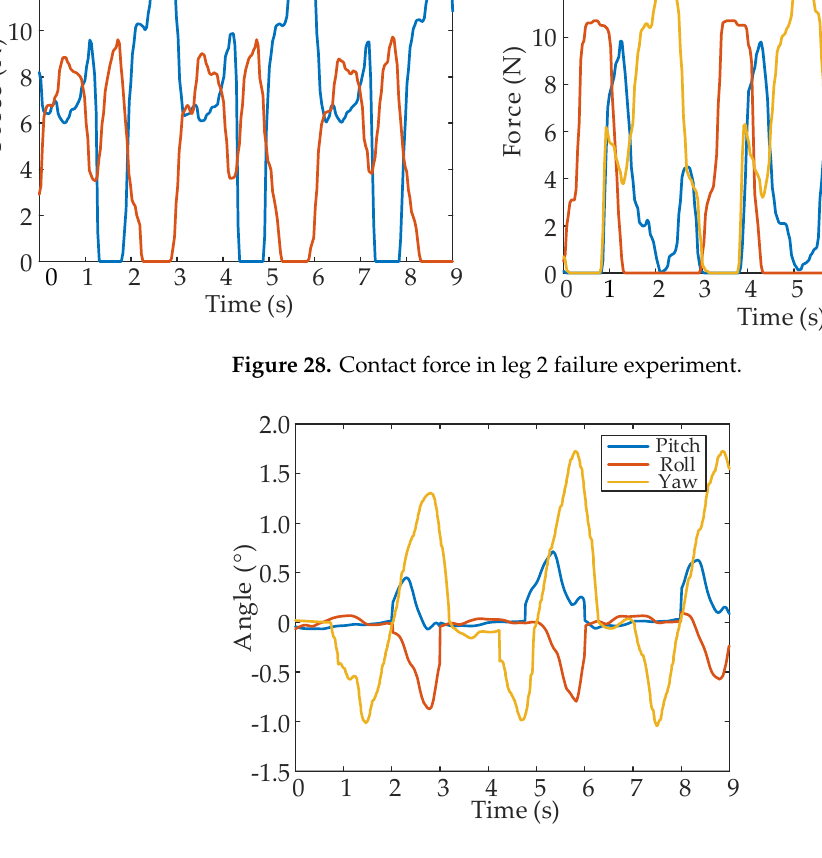
Figure 29. The pitch, roll and yaw angle of the COG in leg 2 failure experiment.